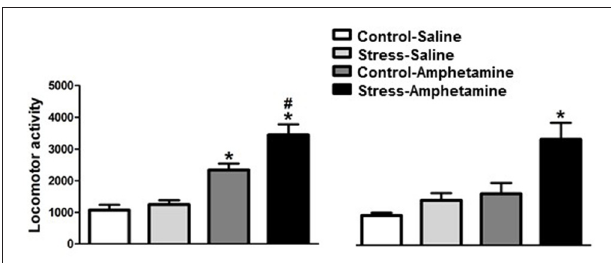
FIGURE 1 | Cross-sensitization between stress and amphetamine in adult and adolescent rats. ∗ p < 0.05 compared to CONTROL-SALINE and STRESS-SALINE; # p < 0.05 compared to CONTROL-AMPHETAMINE.